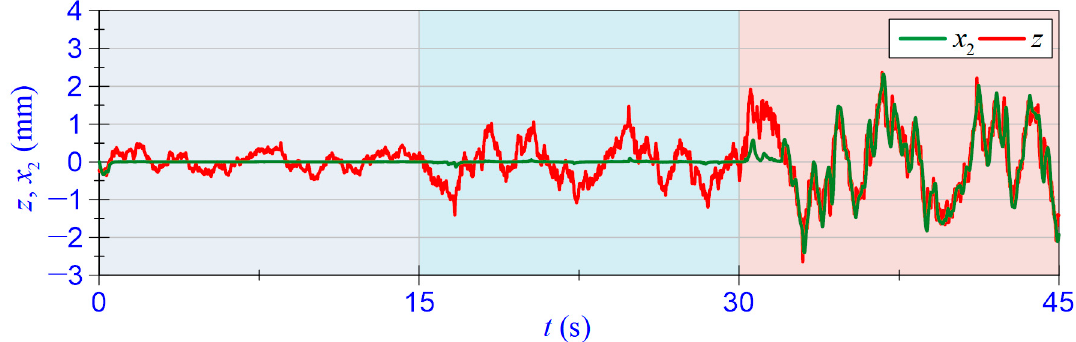
Figure 10. Time patterns of displacement (cid:1878) and (cid:1876) (cid:2870) —HVRS.